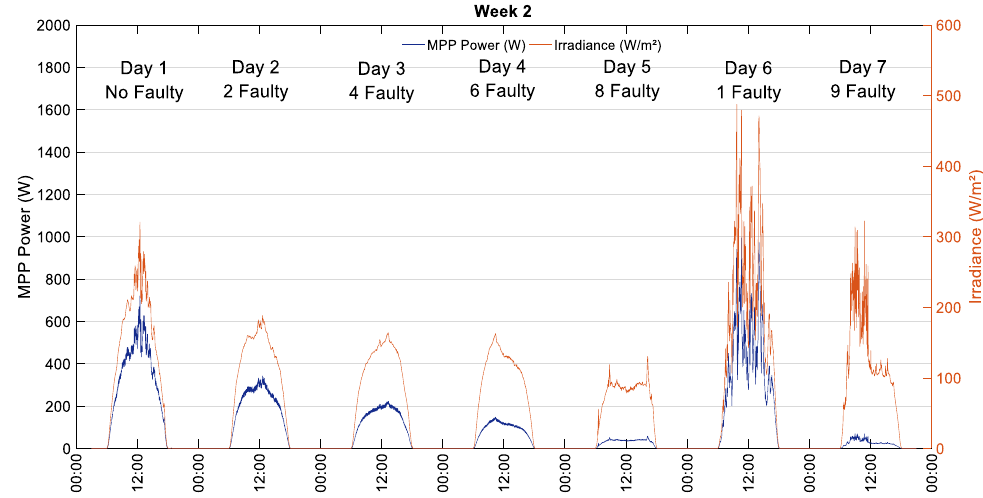
Figure 14. System 1 experimental results on week 2 for irradiance G and P MPP.